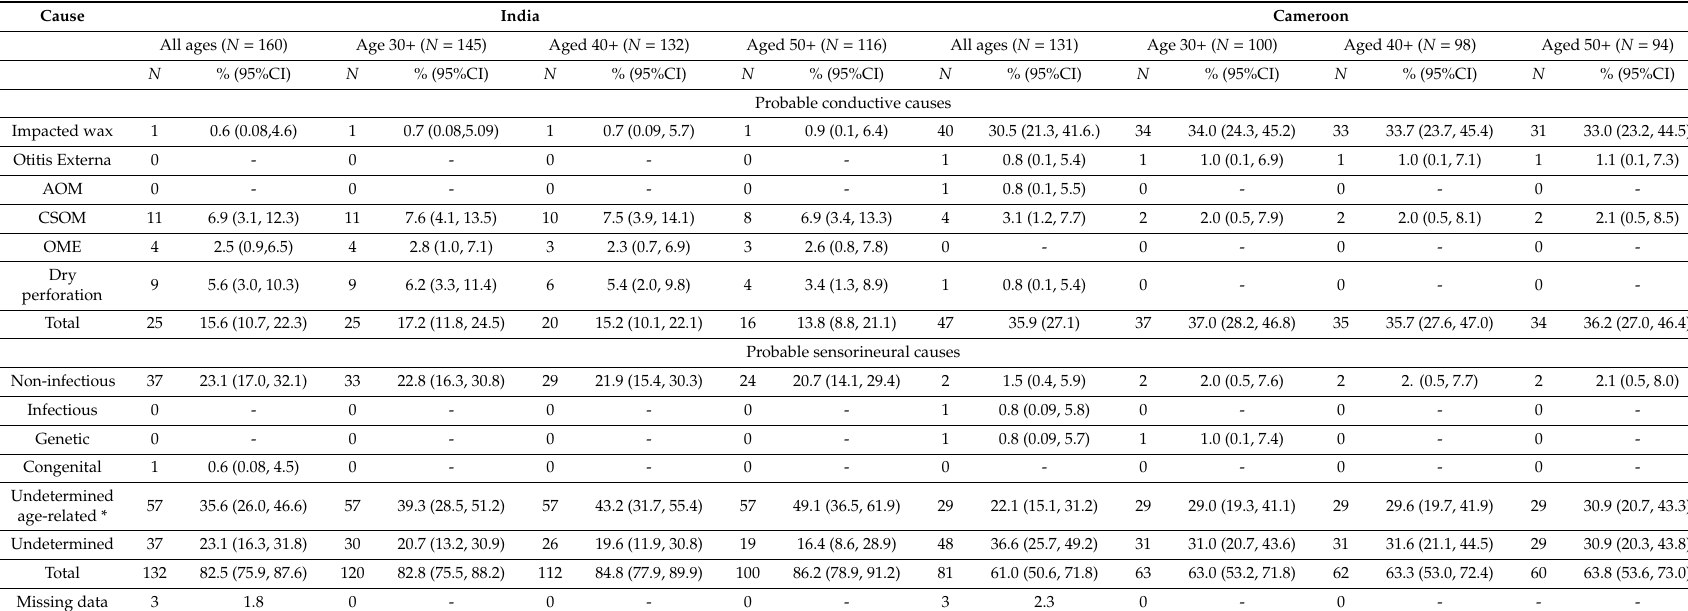
Table A1. Probable causes of hearing loss in the population for all-ages and those aged 40 and 50